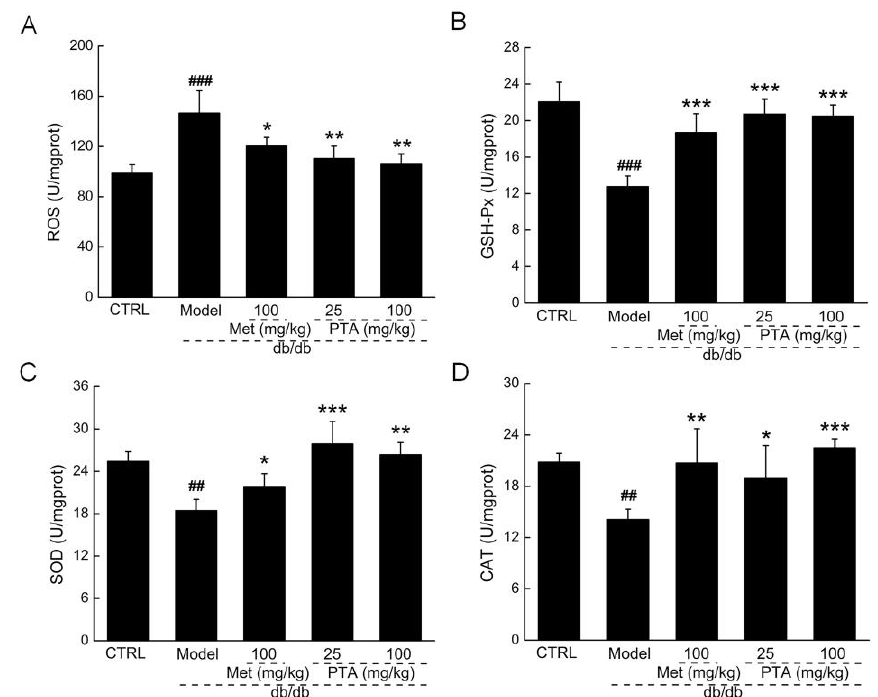
Figure A1. E ff ects of PTA on oxidative stress-related factors in the kidneys of db / db mice. PTA enhanced the levels of ( A ) reactive oxygen species (ROS), and it reduced ( B ) glutathione peroxide (GSH-Px), ( C ) superoxide dismutase (SOD) and ( D ) catalase (CAT) in the kidneys of db / db mice, as detected via ELISA. Data are presented as means ± SD (n = 12). ## p < 0.01 and ### p < 0.001 vs. db / m + mice, * p < 0.05, ** p < 0.01 and *** p < 0.001 vs. non-treated db / db mice.